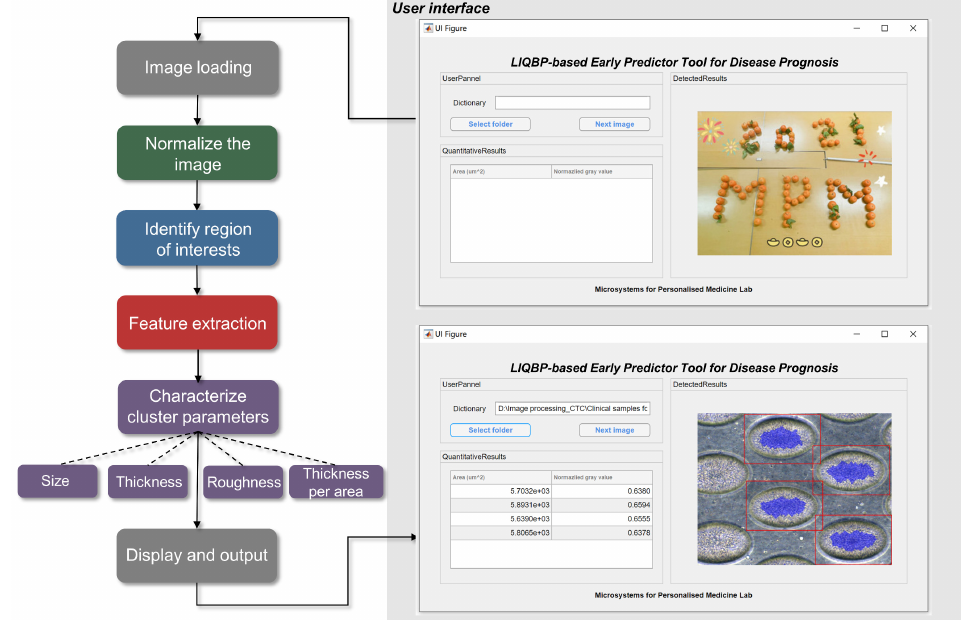
Figure 2. Procedures of LIQBP with multiple phenotypes analysis. User interfaces and the workflow of LIQBP with label-free phenotyping analysis: the image was normalized by flat-field correction; regions of interest (ROI) were identified sequentially; cluster size and thickness were displayed and saved for further analysis.